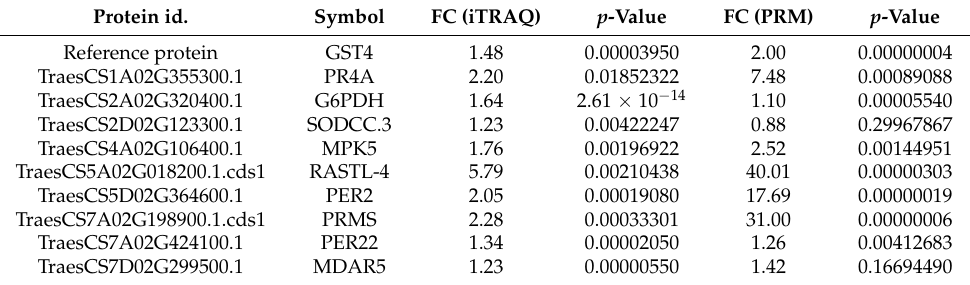
Table 1. Confirmation of differentially expressed proteins using parallel reaction monitoring (PRM) analysis. FC stands for “fold